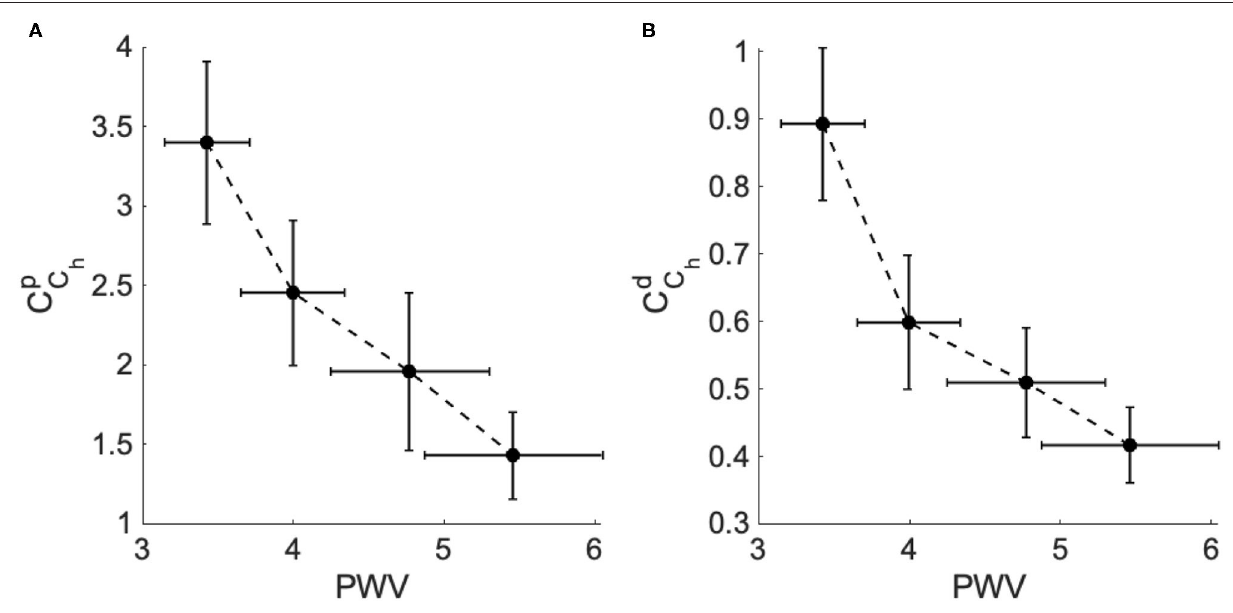
FIGURE 6 | The fractional-order compliance evaluated at the heart pulsation ( C C dataset 2. (A) PWV vs. the proximal fractional-order compliance ( C p C